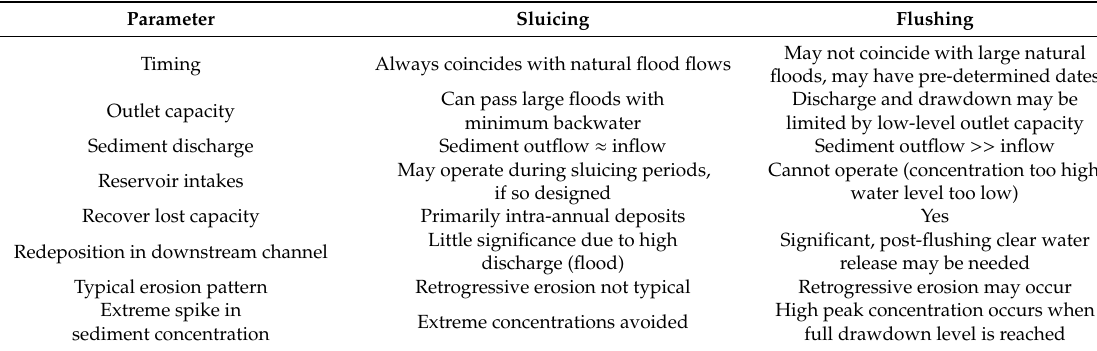
Table 3. Di ff erentiation between Sluicing and